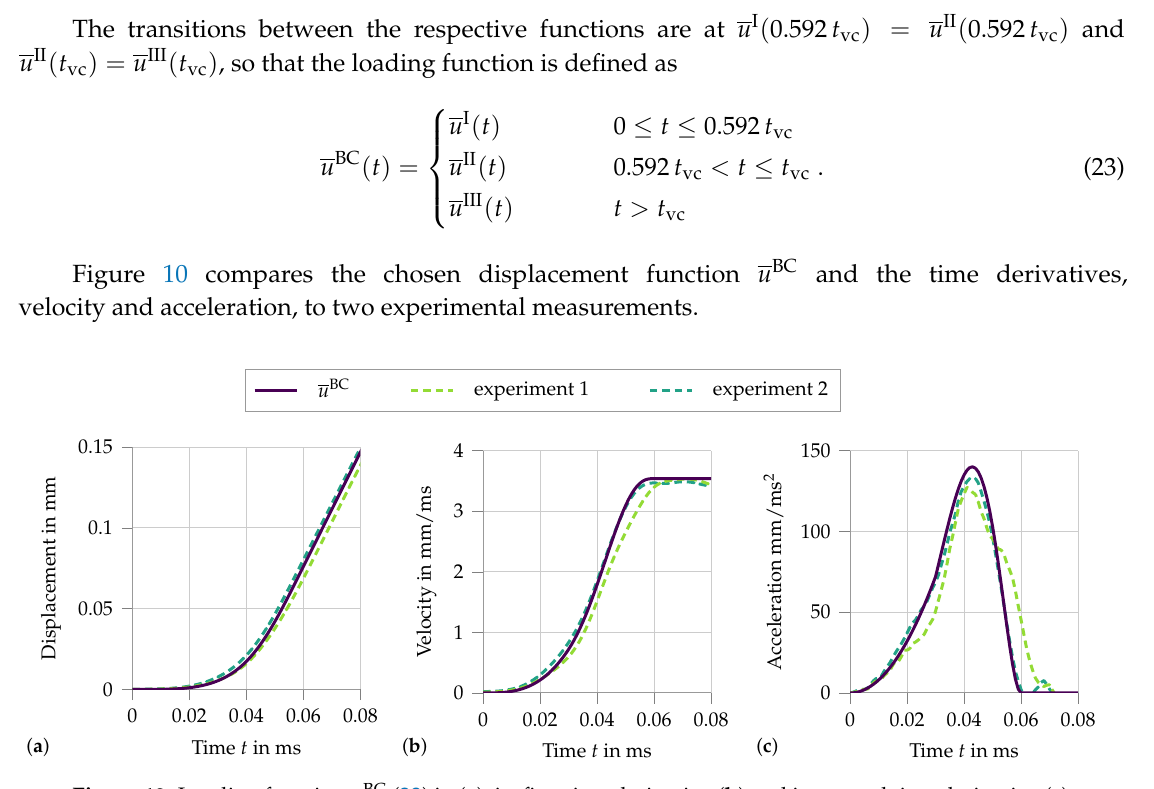
Figure 10. Loading function u BC (23) in ( a ), its first time derivative ( b ) and its second time derivative ( c ), compared to the two experiments from [5], with t vc = 60 µ s and v c =